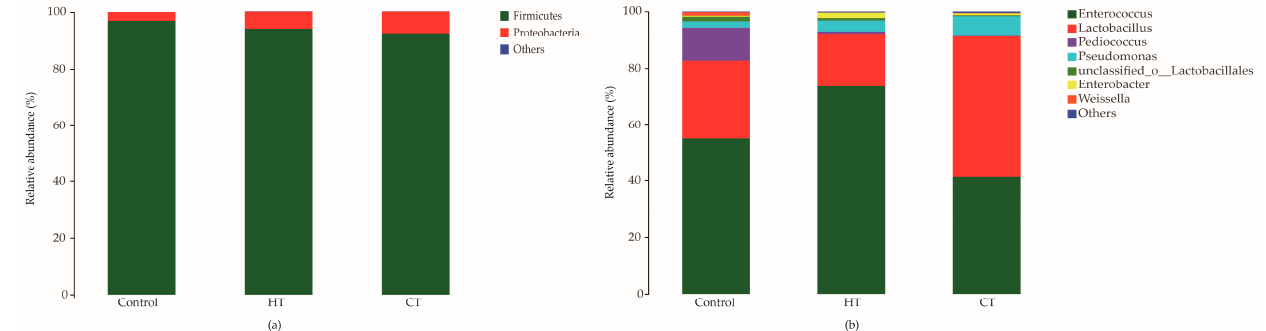
Figure 2. The structure of the bacterial community in silages at the phylum ( a ) and genus levels ( b ). HT = hydrolysable tannin; CT = condensed tannin.